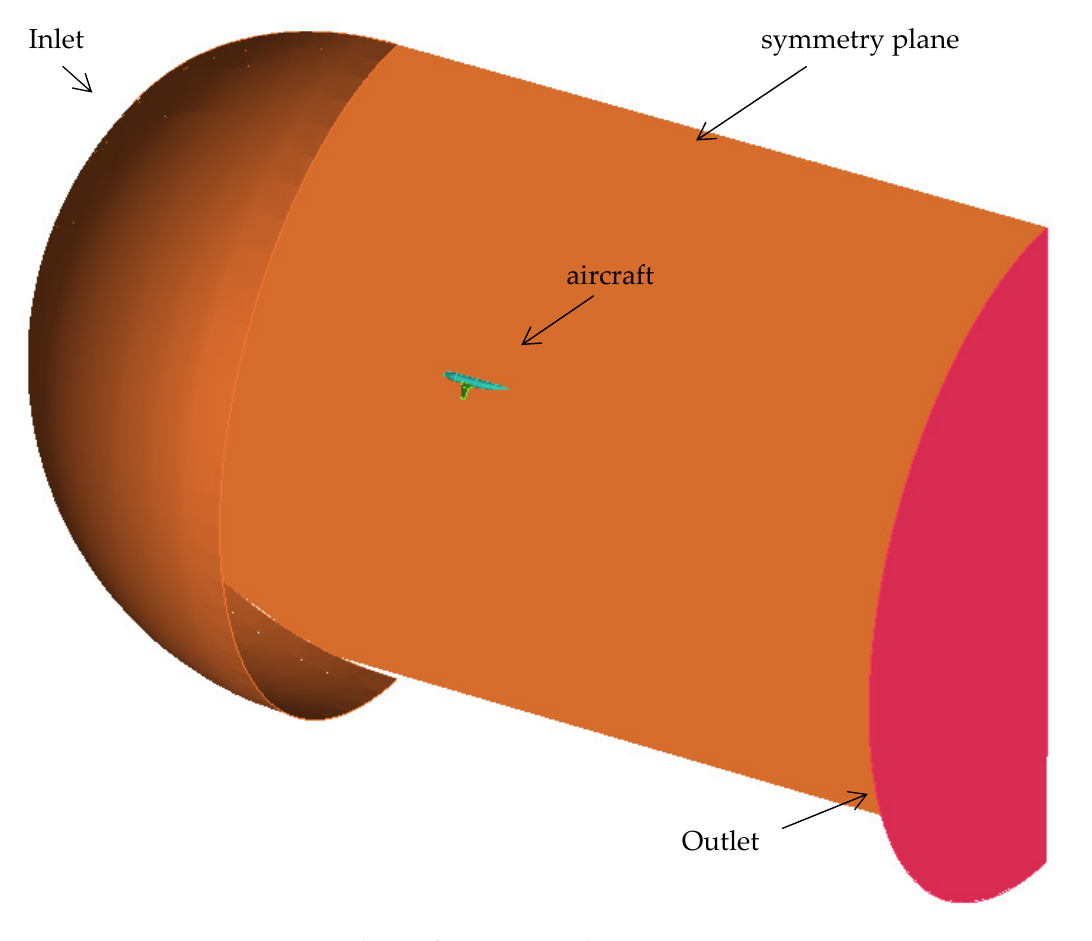
Figure 5. Boundaries of computation domain.